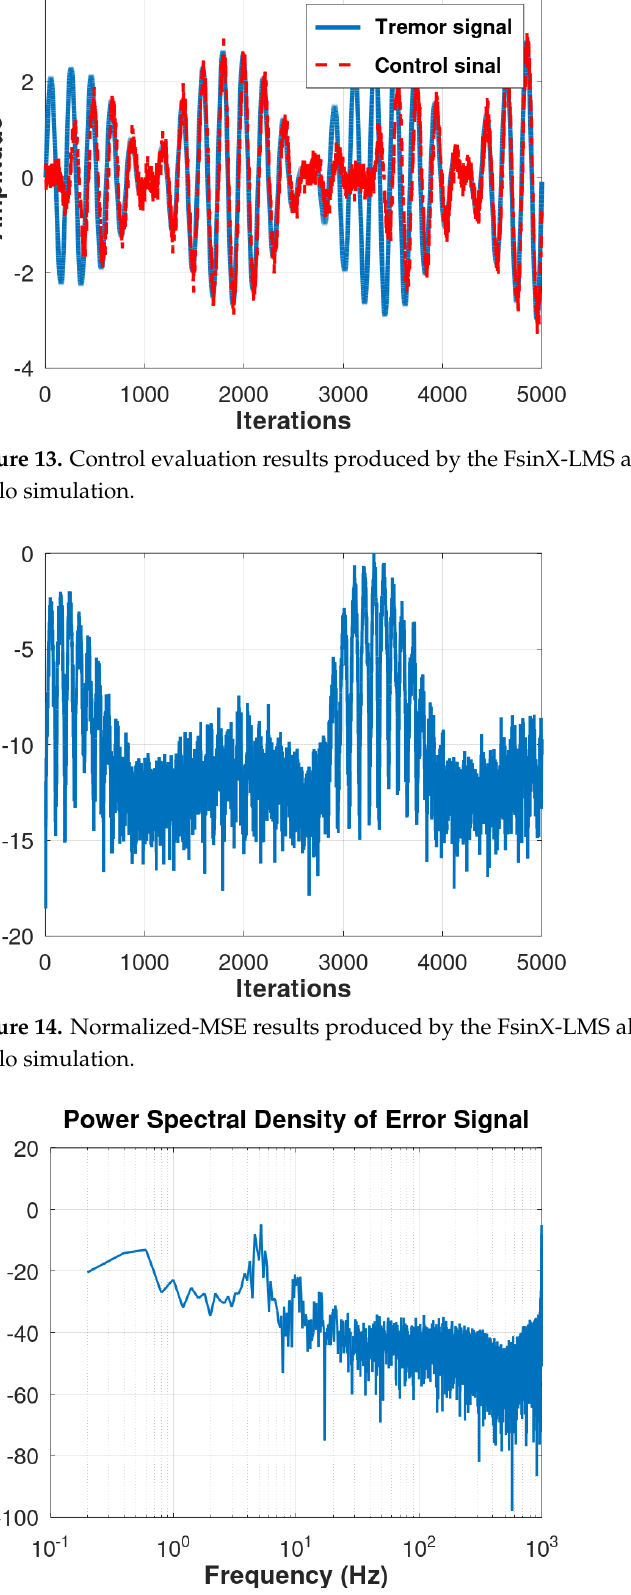
Figure 15. Behavior of the power spectral density (PSD) of the error signal by Fx-LMS in the pathological tremor control